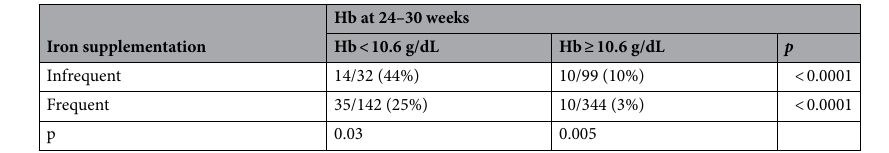
Table 3. Rate of anemia at delivery (Hb < 10.5 g/dL) according to Hb level at 24–30 weeks and iron supplementation. This table addresses the 617 women who responded the question regarding iron supplementation use during pregnancy. Hb,